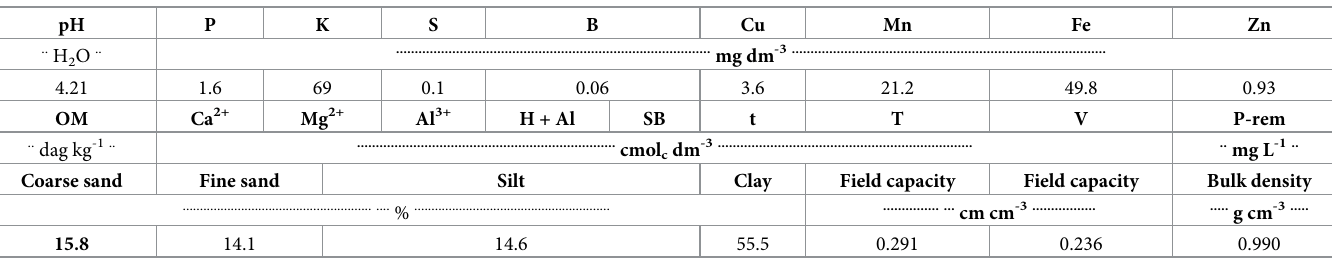
Table 1. Chemical and physical attributes of the soil used in the drainage lysimeters. Vic¸osa-MG, DEA-UFV, 2017.